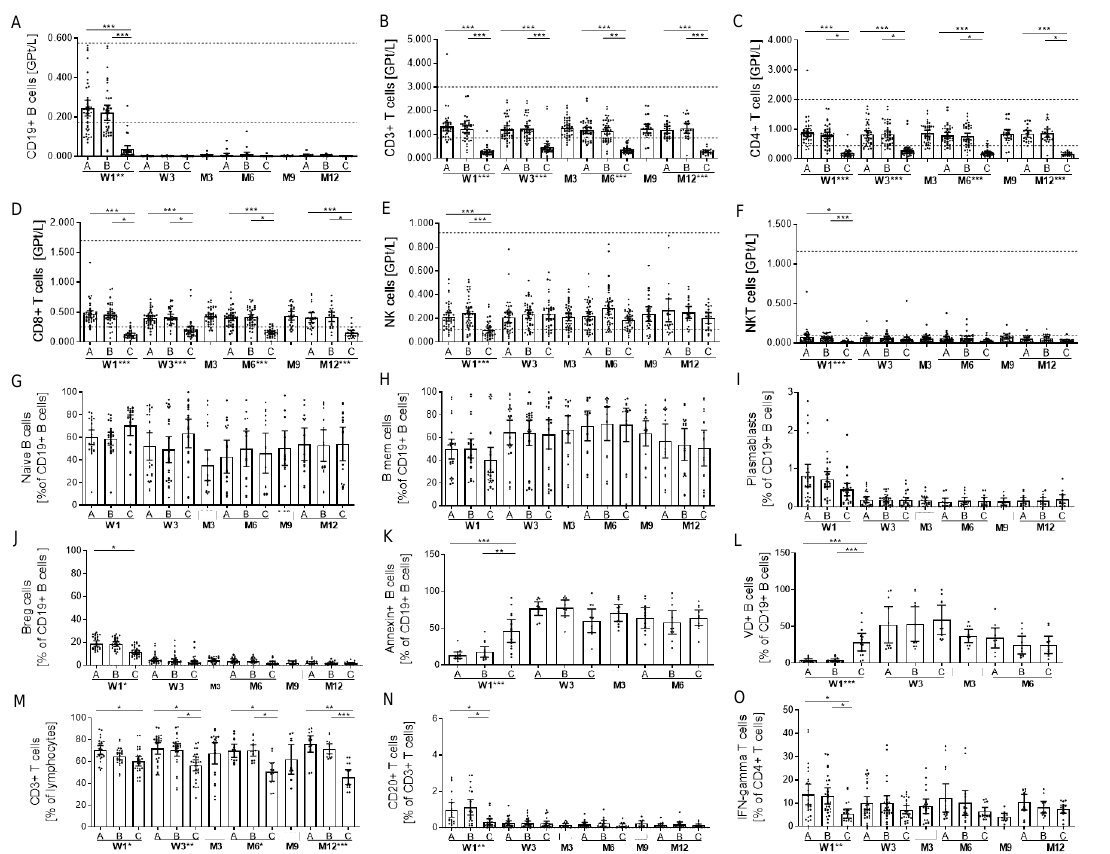
Figure 2. Cell count of selective immune cell sub-populations during OCR. ( A – F ) Absolute cell count of peripheral lymphocyte subsets evaluated by FACS analysis. Relative cell count of CD19 + CD27 − naïve B cells ( G ), CD19 + CD27 + memory B cells ( H ), CD19 + CD27 + CD38 + CD138 + plasmablasts ( I ) and CD19 + CD27 + CD38 + CD5 + B regulatory cells ( J ) are depicted. ( K , L ) Apoptotic B cells (annexin, A) and death cells (viability dye, VD) were investigated in a selected subgroup ( n =